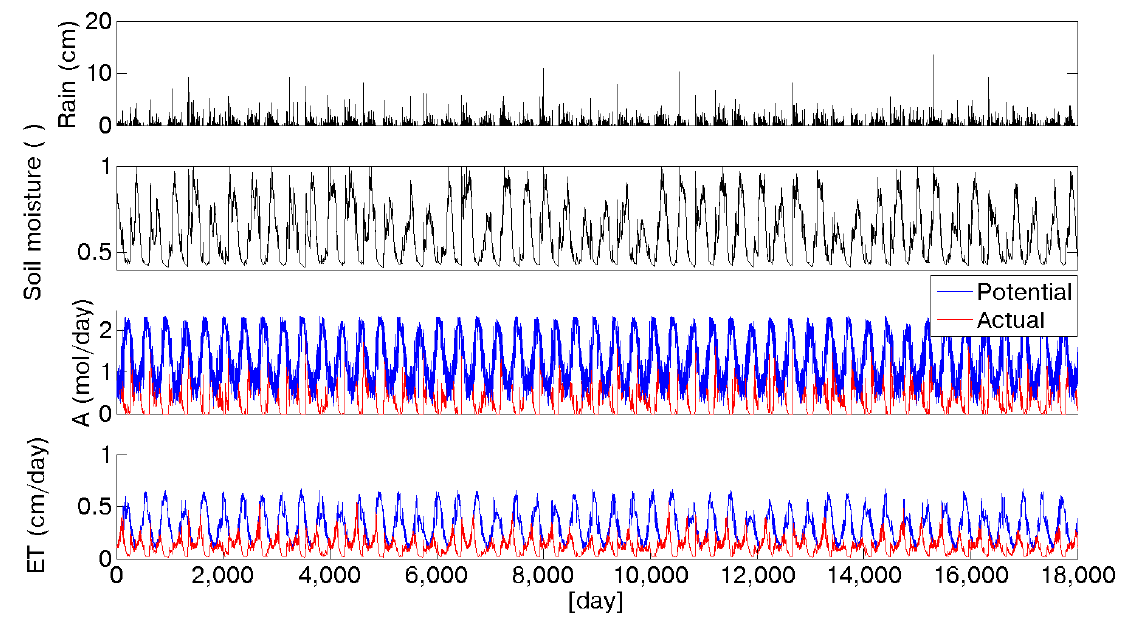
Figure 4. 50 years of daily stochastic rainfall and soil moisture series in the 2090 scenario. The two bottom rows show the comparison between potential (blue line) and water limited (red line) assimilation and evapotranspiration.